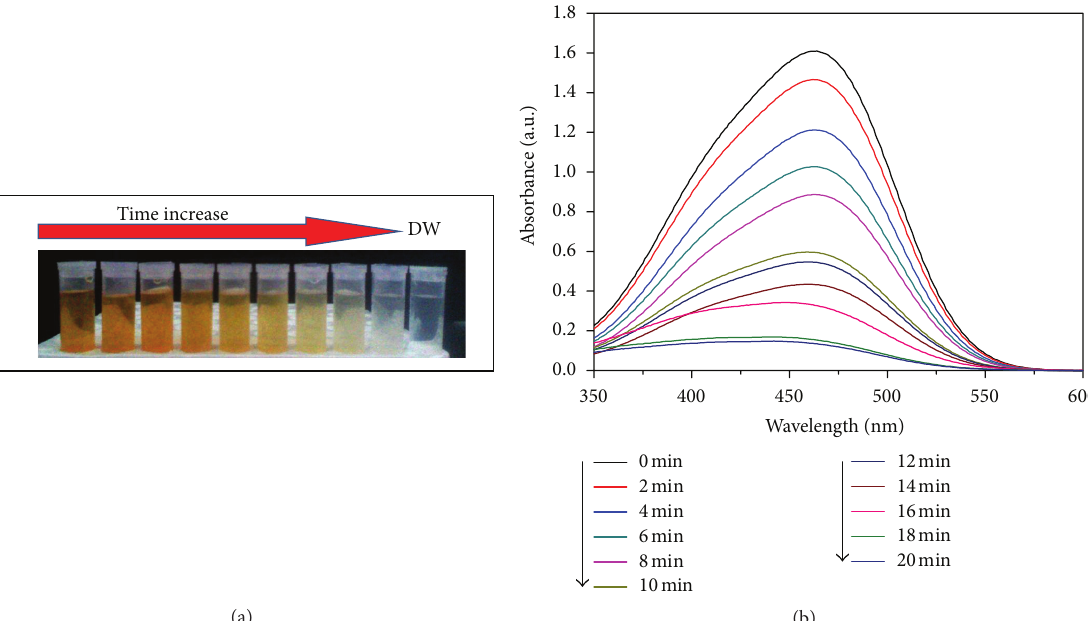
Figure 6: (a) Photographs and (b) adsorption spectra of MO solutions in the presence of porous TiO 2 nanotubes irradiated by UV lamp at different periods of time.